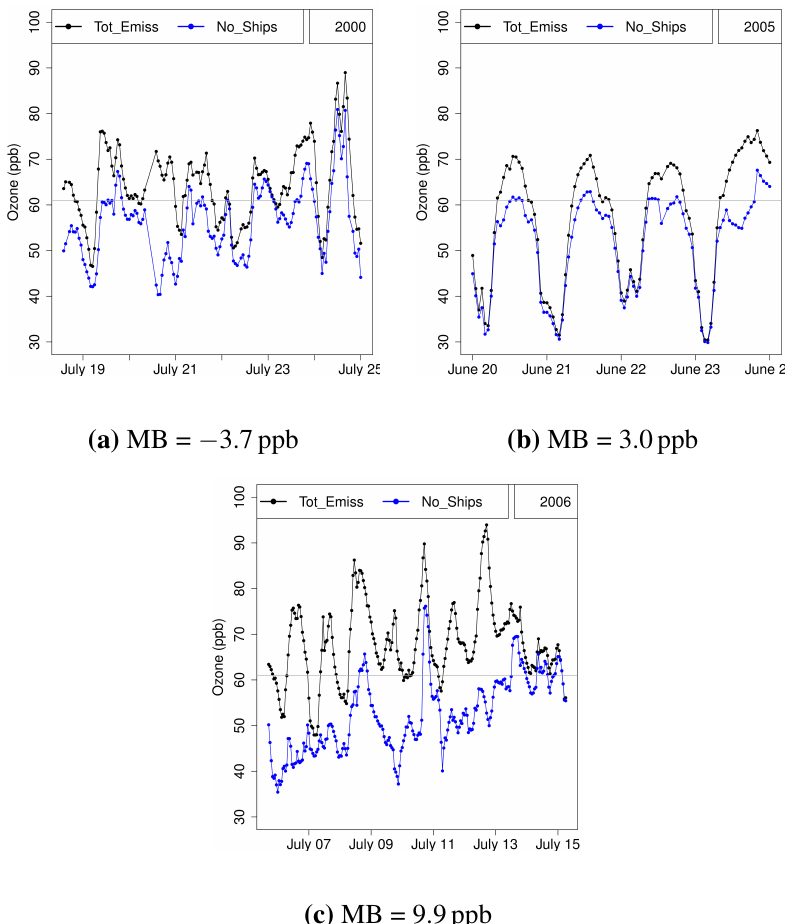
Figure 9. Examples of the difference in O concentration with and without ship emissions 3 along the route of the R.V. Urania, for ( a ) 2000, ( b ) 2005 and ( c ) 2006. The MB between observed and modeled values is also reported. The mean bias (MB) between observed and modeled (Tot_Emiss scenario) values is also